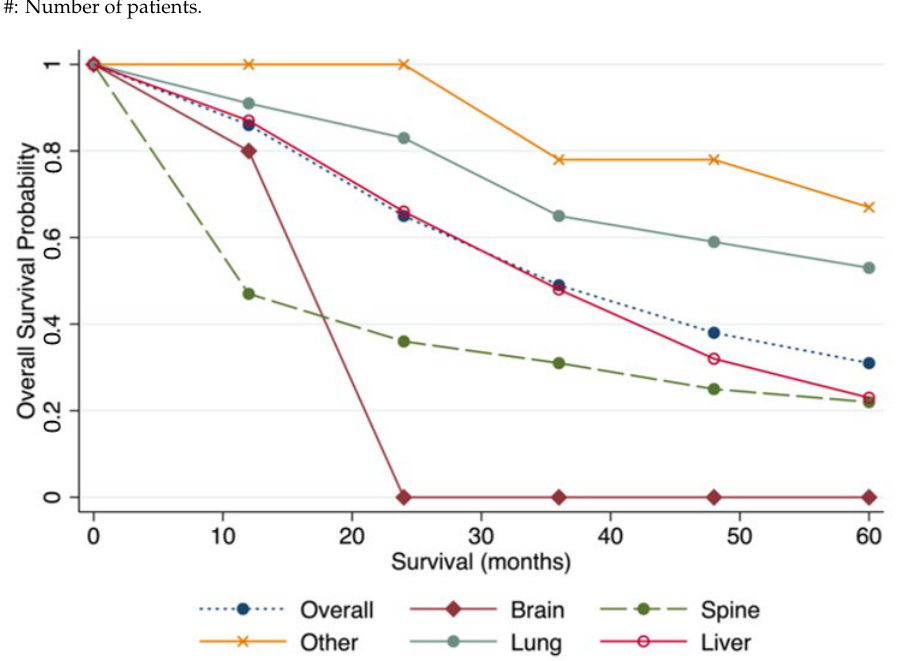
Figure 1. Pooled overall survival by site of